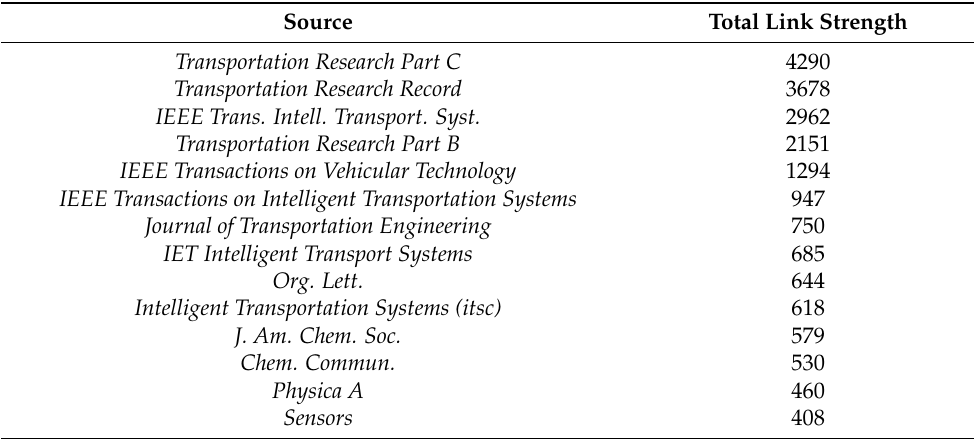
Table 3. Most influential sources after manually resolving name duplications.